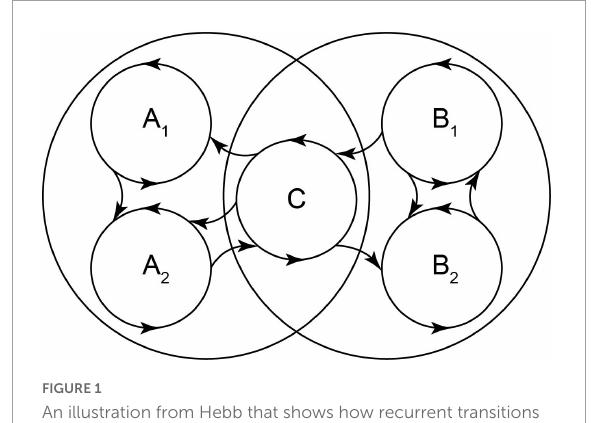
FIGURE1 An illustration from Hebb that shows how recurrent transitions between neuronal ensembles might be (represented as “systems” in Hebb’s postulate). It proposes the possibility that ensemble C can serve as a link between two ensemble chains, thus participating in both, being the neuronal substrate for associative learning (Hebb, 1949). In addition, a modular theory can be inferred: each ensemble has inputs and outputs and performs a task step. Alternating activity between them performs the complete task or routine. Alternative pathways are possible to link different procedures. Tools described in the present article can show that this idea can be demonstrated with identified neuronal ensembles (cf., Figure 5